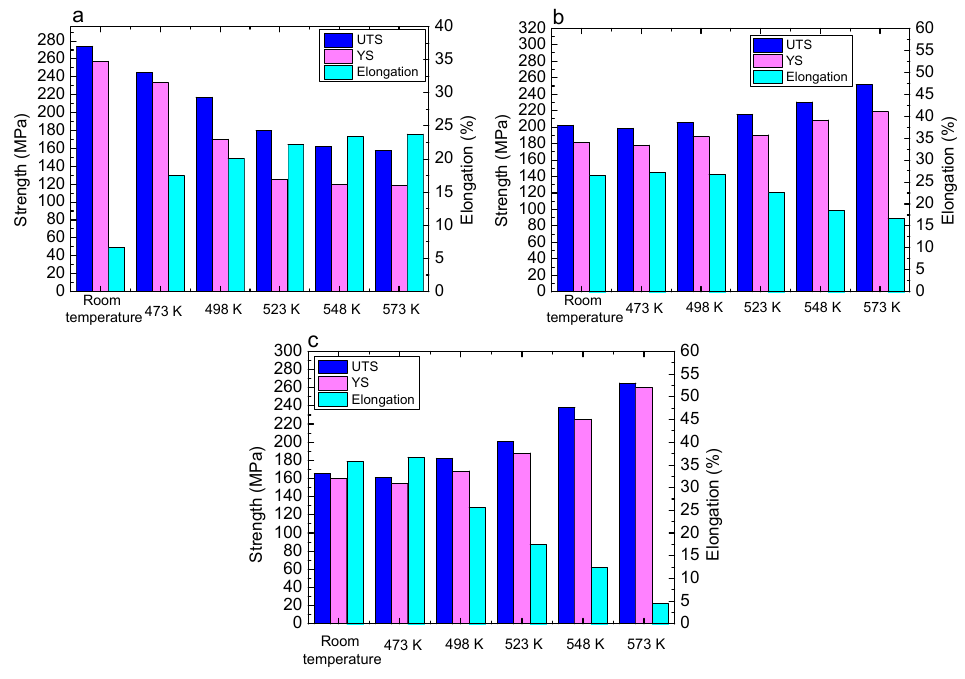
Figure 11. Mechanical properties of three alloys at different conditions: ( a ) Mg-5Li-3Al-2Zn-0.2Y; ( b ) Mg-8Li-3Al-2Zn-0.2Y; ( c ) Mg-11Li-3Al-2Zn-0.2Y.